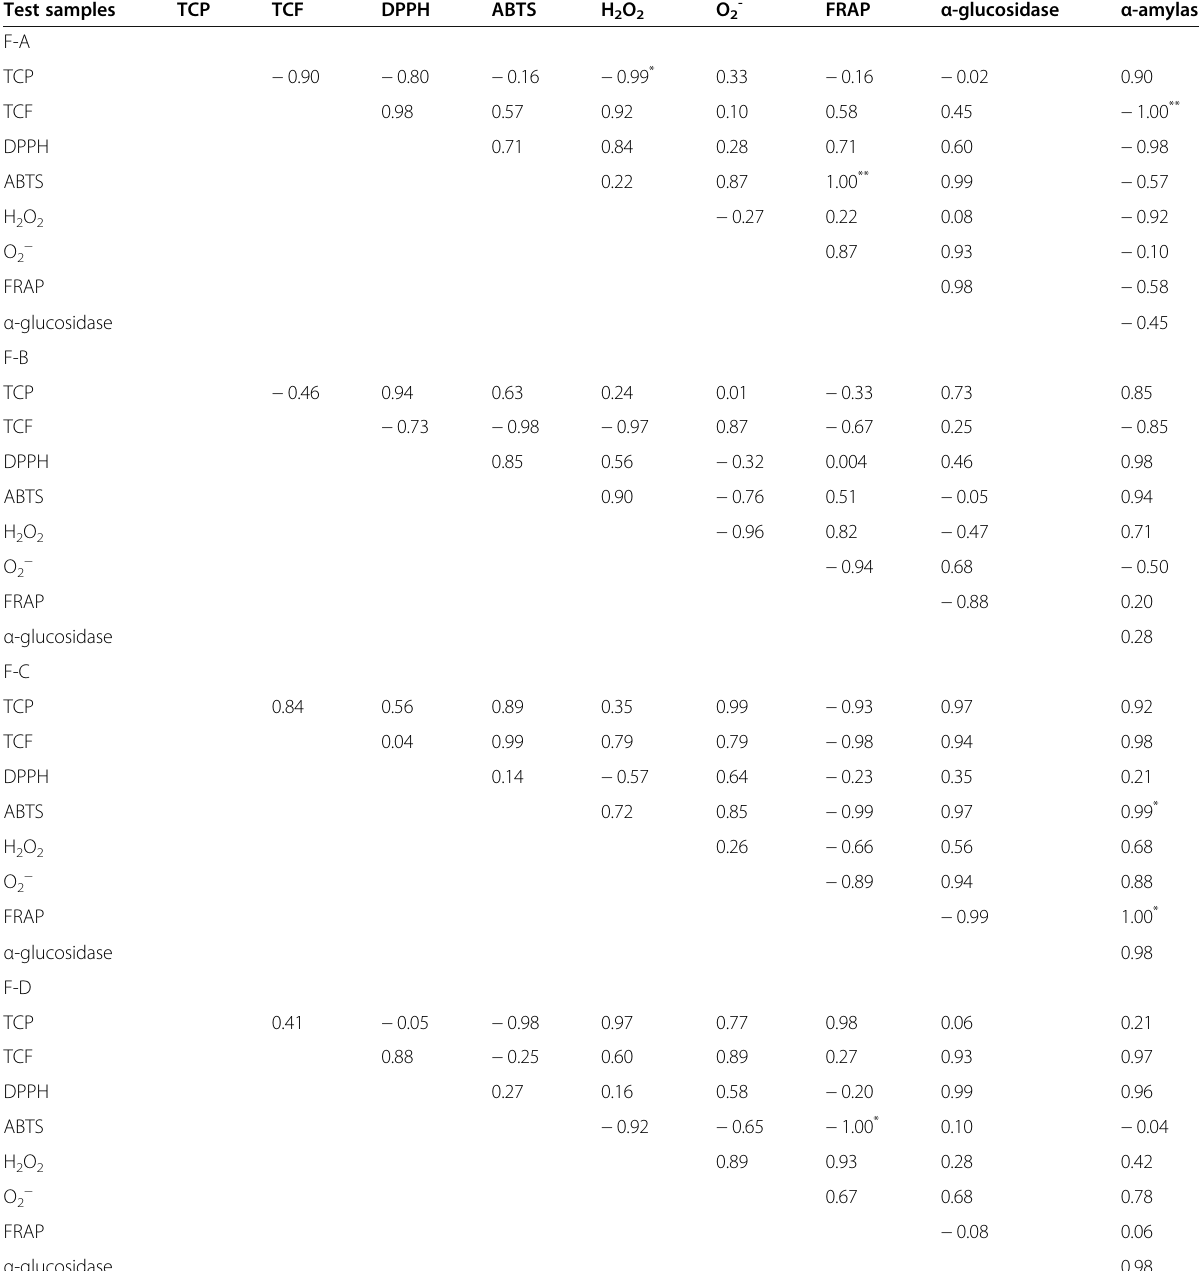
Table 4 Correlation coefficients of Pearson analysis to exhibit a linear correlation between phytochemical content, in vitro antioxidant and in vitro antidiabetic assays in MeCV isolated four pooled fractions Test